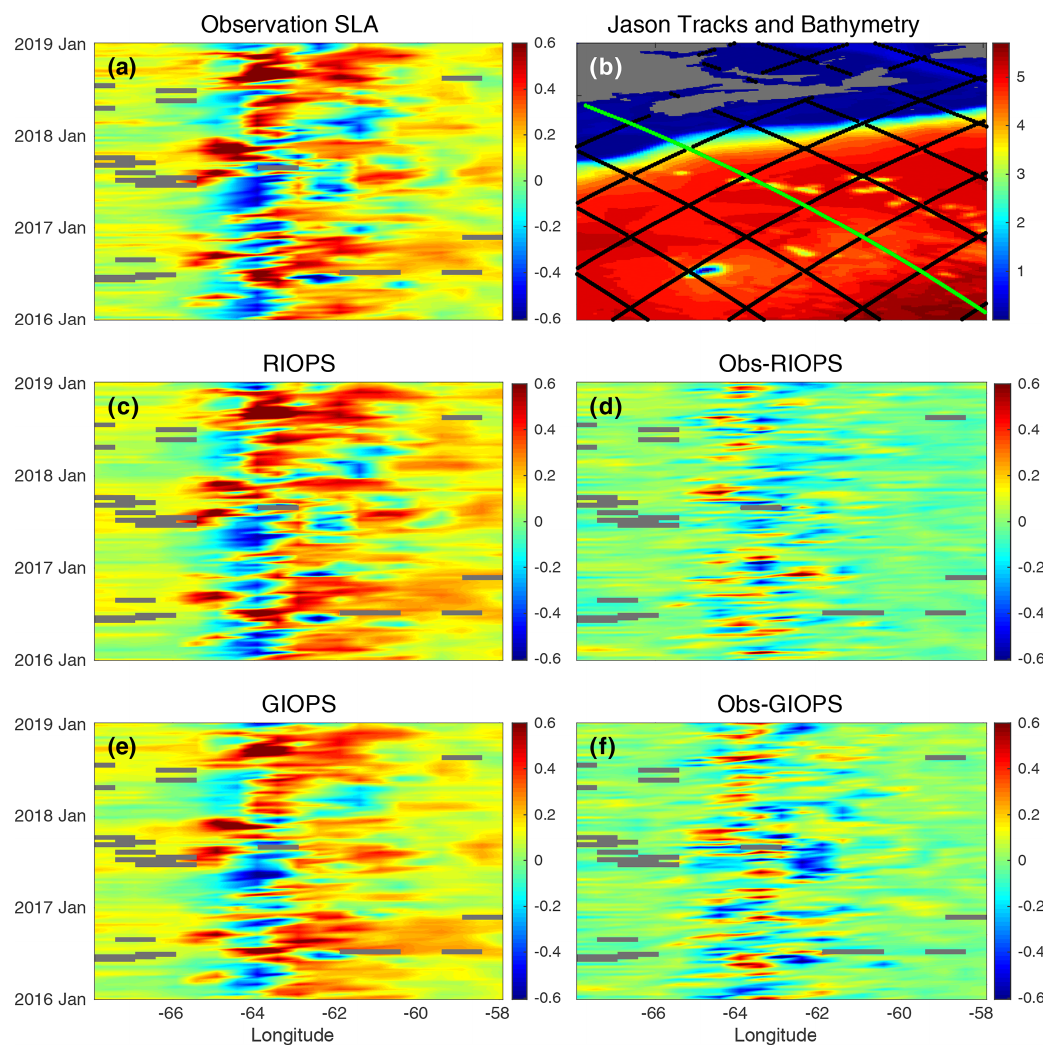
Figure 12. Hovmöller diagrams showing variations in sea level anomaly (SLA; units are meters) for the period 1 January 2016 to 31 Decem- ber 2018 along a repeat altimeter track of the Jason altimeter (green line in panel b , units are kilometers). Observations prior to 7 Septem- ber 2016 are taken from Jason-2, and Jason-3 is used thereafter. Satellite observed values are shown in panel (a) along with values for RIOPSv2 (c) and GIOPSv3 (e) . Differences (obs – model) for RIOPSv2 and GIOPSv3 are shown in panels (d) and (f) , respectively. Periods of missing observations are shown as grey